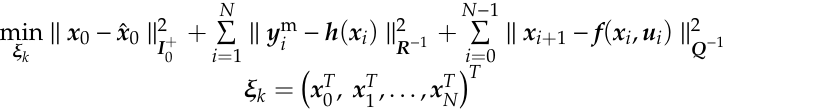
Figure 7. Observer behavior with and without path constraints.